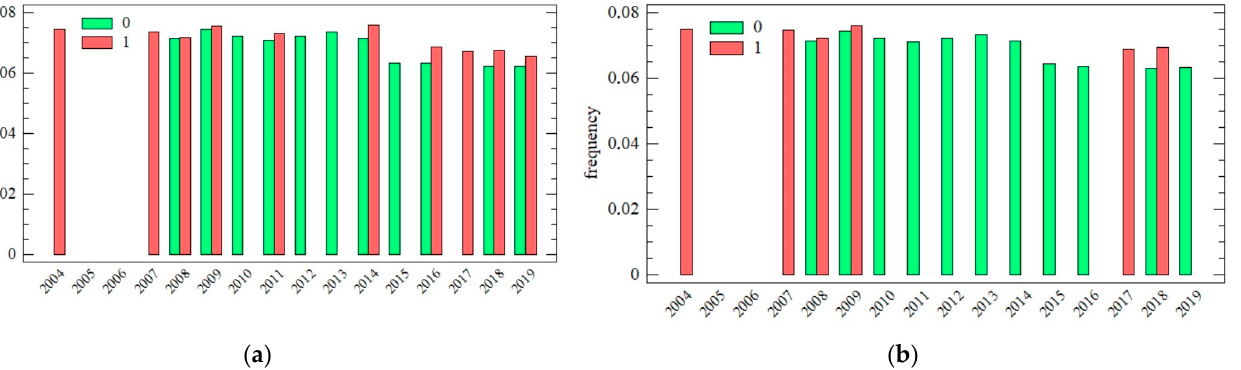
Figure 8. Development of the regressor in the regression function RCR = (a × ln(I)) 2 depending on income and expenditure in the period 2004–2019: ( a ) income; ( b ) expenditure. Note: 0, cooperatives; 1, non-cooperatives.